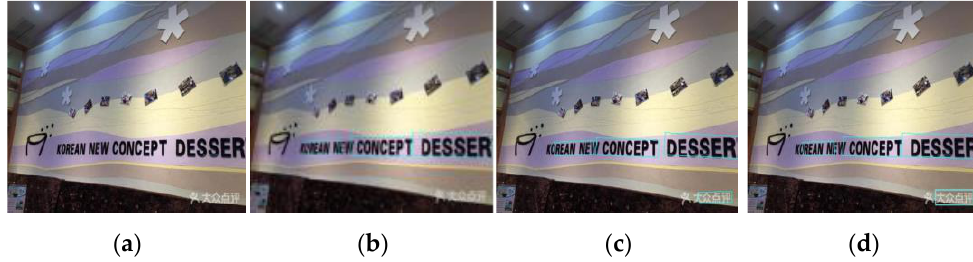
Figure 6. Comparison of the detection effect of slanted text. ( a ) Slanted original text; ( b ) EAST algorithm; ( c ) Hybrid feature pyramid algorithm; ( d ) The algorithm of this paper.